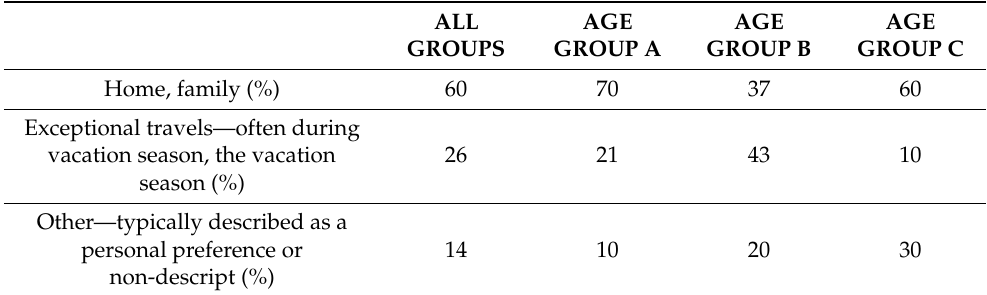
Table 3. Specific associations with past events listed by respondents as tied with preferred aro- matic herbs.